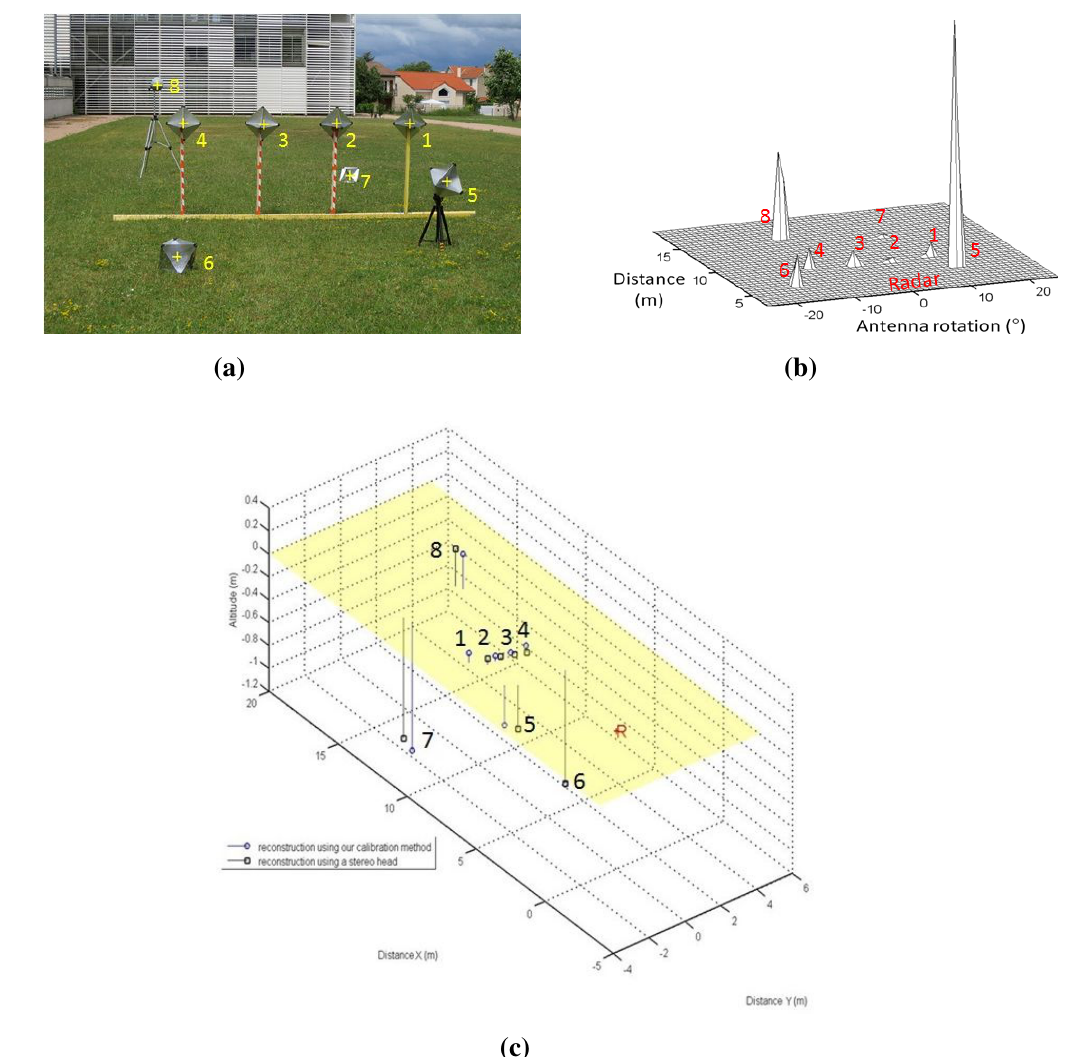
Figure 20. Reconstruction results using the inter-distance constraint for calibration. ( a ) Camera image of the eight canonical targets: one Luneburg lens and seven trihedral corners. The yellow crosses indicate the center of the targets; ( b ) Radar image with eight canonical targets; ( c ) The reconstruction results of both of our reconstruction methods (circular points) and the stereo head method as the ground truth (squared points). The radar position is indicated by the letter